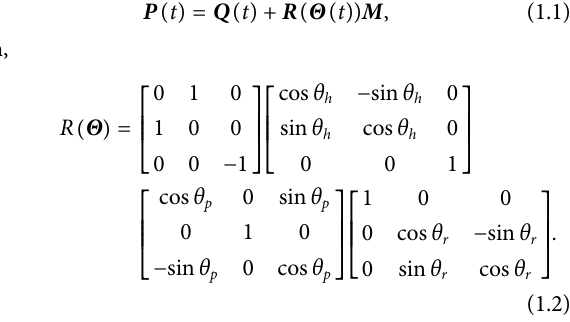
Frontiers in Earth Science |